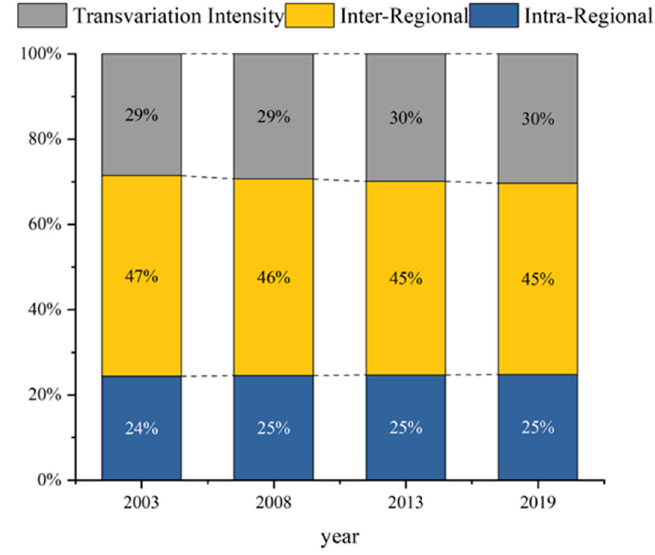
Figure 4. Spatial disequilibrium degree and source contribution rate.